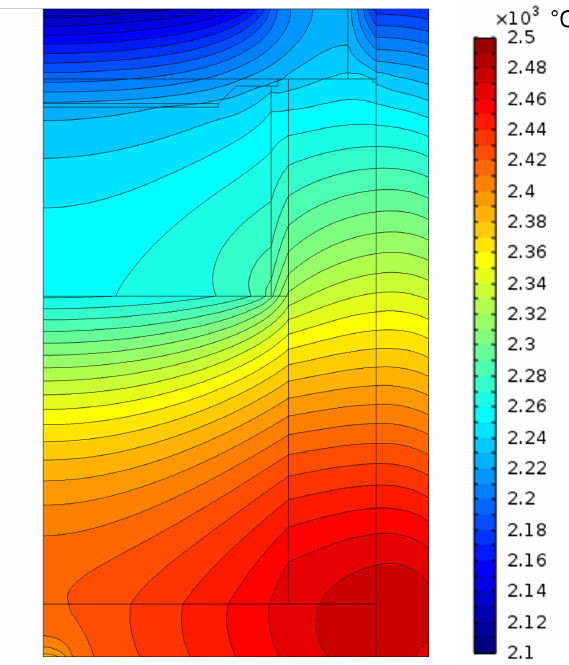
Figure 16. Calculated temperature field of a typical growth cell in a PVT